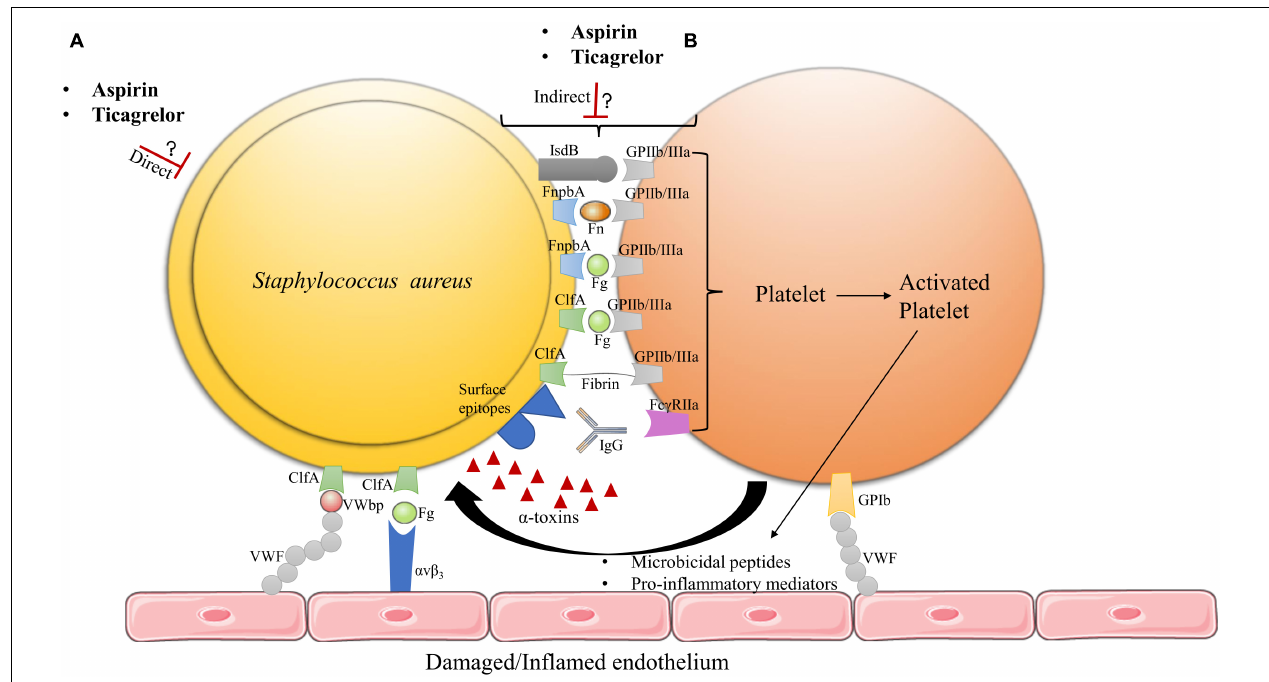
FIGURE 1 | Hypothetical model of aspirin and ticagrelor action on S. aureus IE vegetation. (A) The antiplatelet drugs may exert direct effects on bacteria. (B) Ticagrelor and/or aspirin may inhibit bacteria–platelet interactions by acting on either platelet activation or bacteria toxins, which could also alter the adhesion of these hetero-aggregates on damaged or inflamed endothelia. The exact mechanisms of action of aspirin and ticagrelor on vegetation formation remain to be determined, as well as potential added value of ticagrelor compared to aspirin. FnbpA, fibronectin binding protein A; ClfA, clumping factor A; IsdB, iron regulated surface determinant B; Fn, fibronectin; Fg, fibrinogen; IgG, immunoglobulins; VWF, von Willebrand factor; VWbp, von Willebrand factor binding protein (Claes et al., 2017, 2018; Liesenborghs et al.,